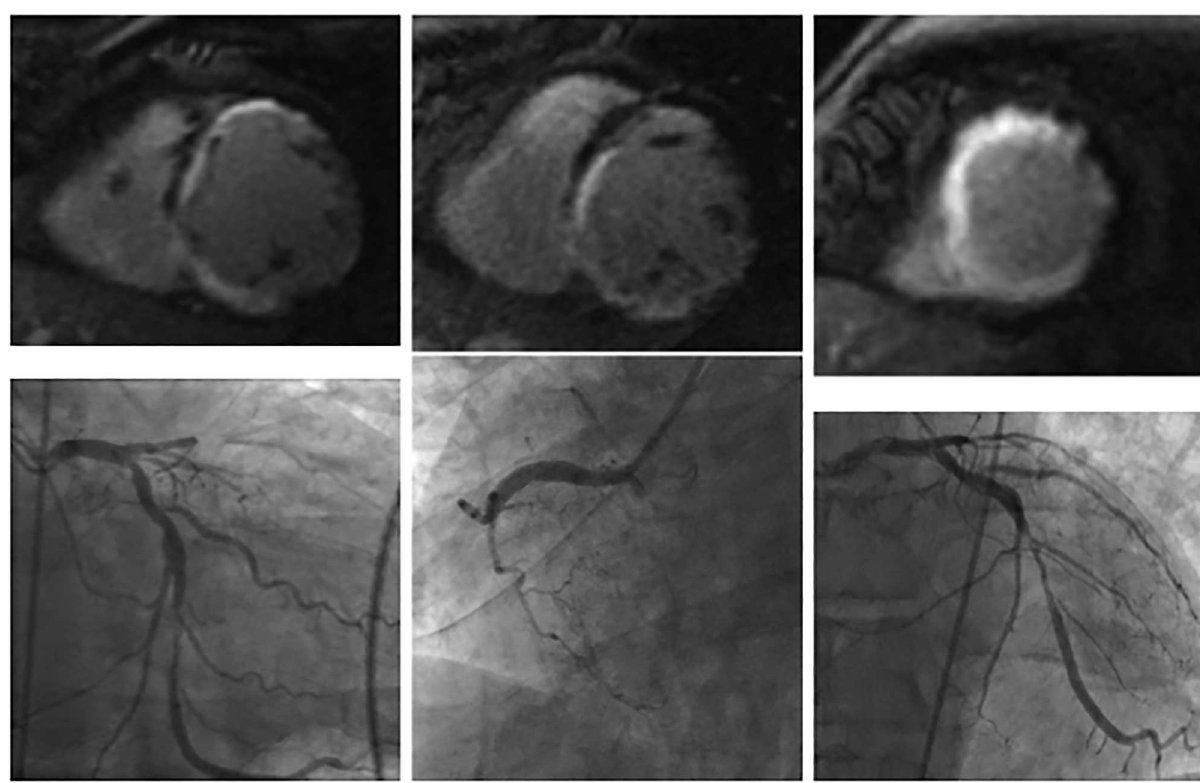
Fig 2. Multiple Infarcts on CMR and CA. CMR with evidenceof multiple infarcts in LAD, RCA, and LCx distribution(A-C). Angiography with high-grade stenosis in LCx and LAD, 100% stenosisRCA